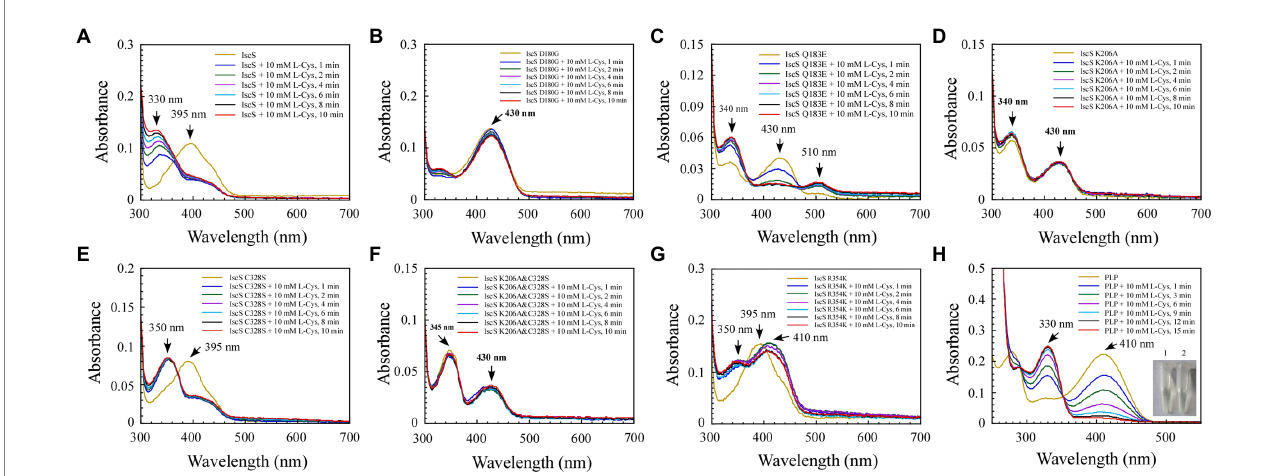
FIGURE 5 The reaction progress of Escherichia coli IscS is dynamically displayed in the experiment of incubating and binding wild-type IscS (IscS-WT) and its variants with L-cysteine (substrate) in vitro . (A–G) UV–visible spectral changes of IscS-WT and its variants (25 μ M) upon the addition of 10 mM of L-cysteine. Arrows show changes in absorption peaks at these wavelengths. It is noted that CD incubation with 10 mM of L-cysteine at room temperature for 10 min results in the decline or disappearance of the absorption peak at 395 nm or 430 nm, whereas a new set of absorption peaks correspond with the appearance of a series of reactional intermediates in an unstable manner; (H) The external ketimine or aldimine intermediates produced by the in vitro binding between PLP (50 μ M) and L-cysteine (substrate) were used as the positive controls. The insets show photographs of PLP solution (1) and its reaction with L-cysteine (10 mM) after 15 min (2). The data are representative of three independent experiments.